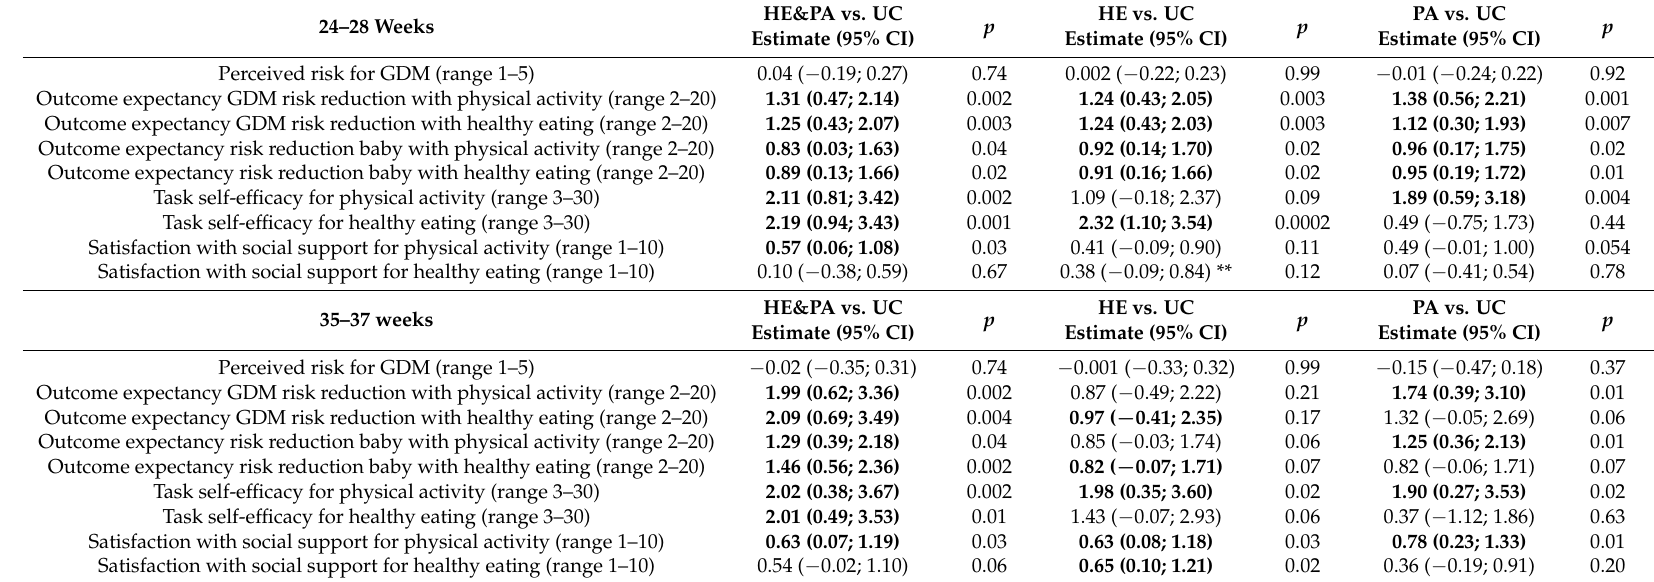
Table 3. Intervention effects on psychological variables at 24–28 and 35–37 weeks (a